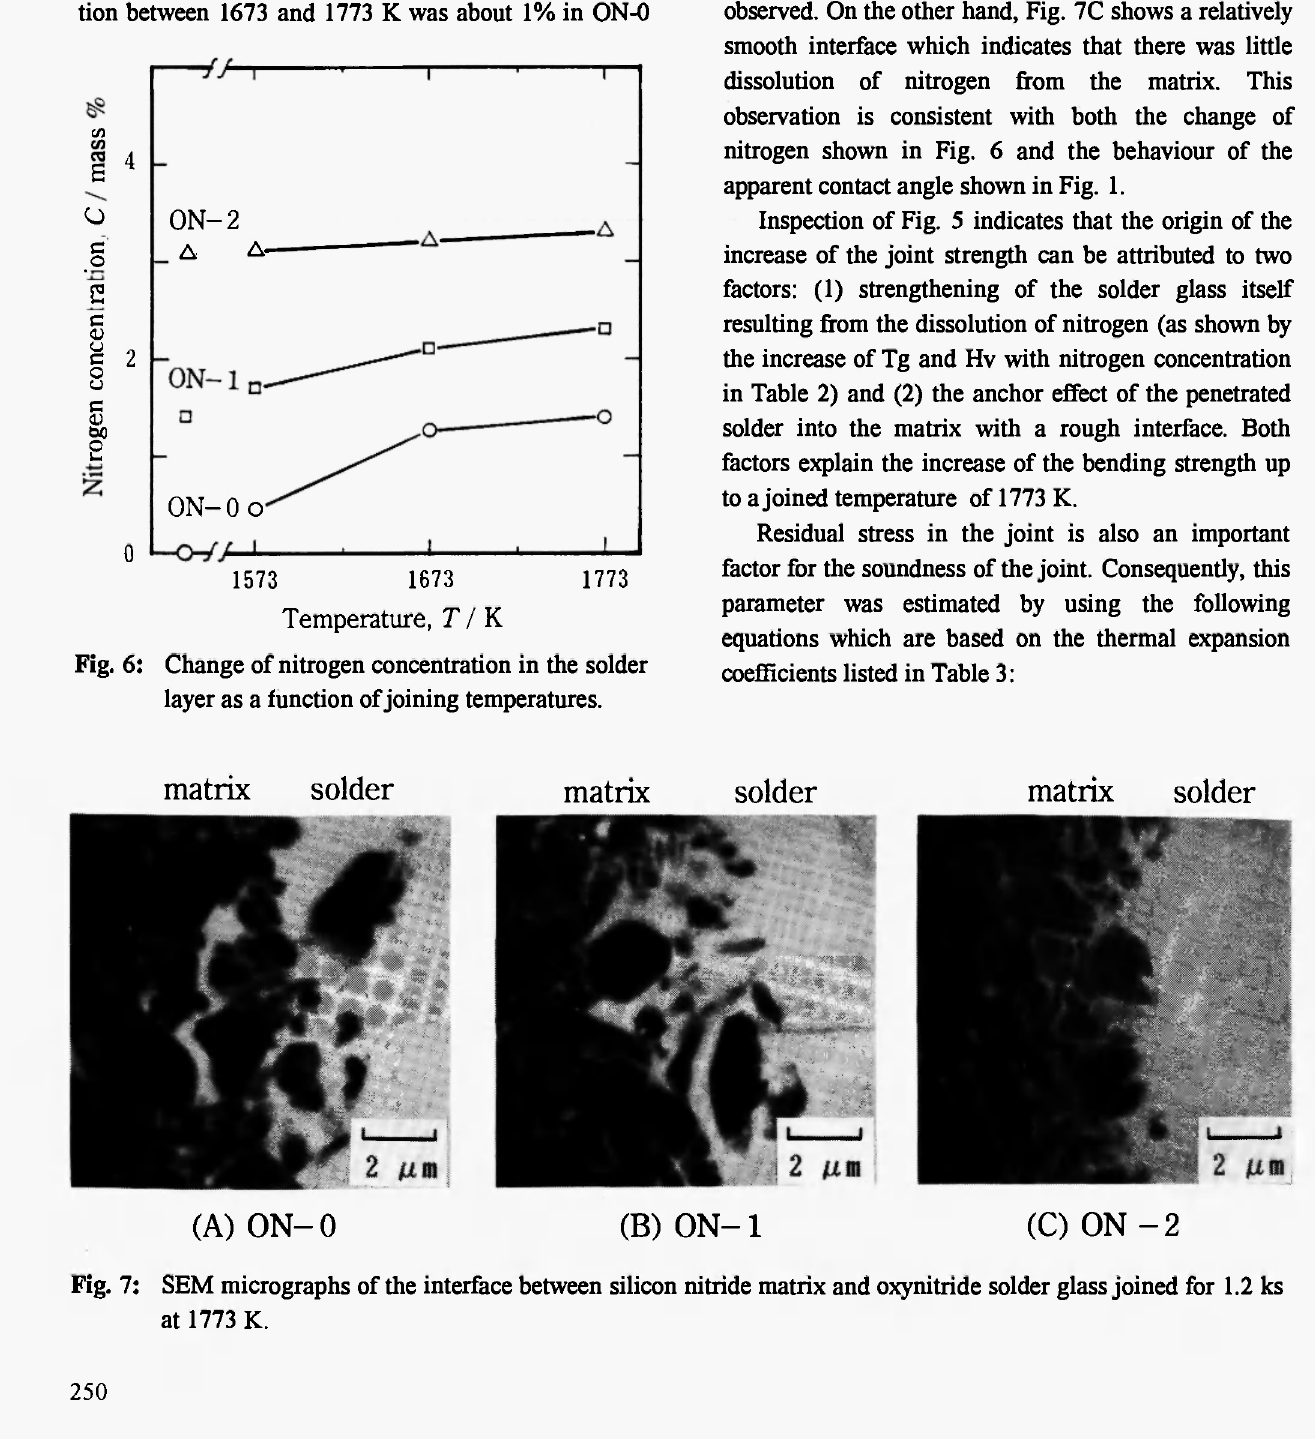
6: Change of nitrogen concentration in the solder layer as a function of joining temperatures.